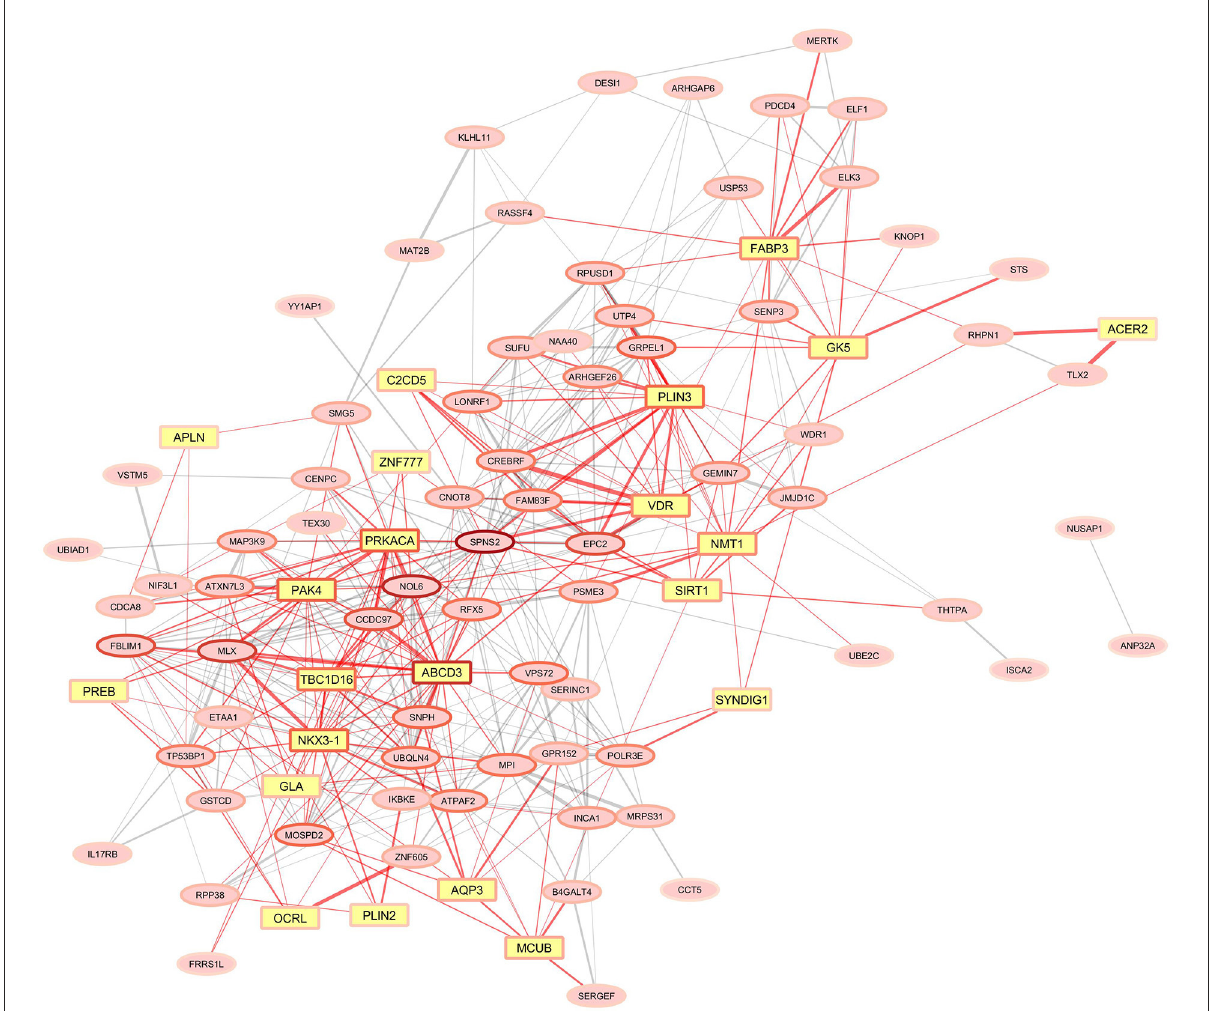
FIGURE4 Gene co-expression network for the lightyellow module significantly correlated with milk fat-yield reduction due to the MFD-inducing diet. Yellow squared nodes (yellow genes) represent genes functionally associated with mammary lipid metabolism in ruminants. Red edges indicate the connections of yellow genes in the network. The width of the edges corresponds to the weight in the WGCNA. The border color of the node is related to the number of connections, reddish nodes represent highly connected hub genes, and lighter red border colors of nodes represent genes with fewer